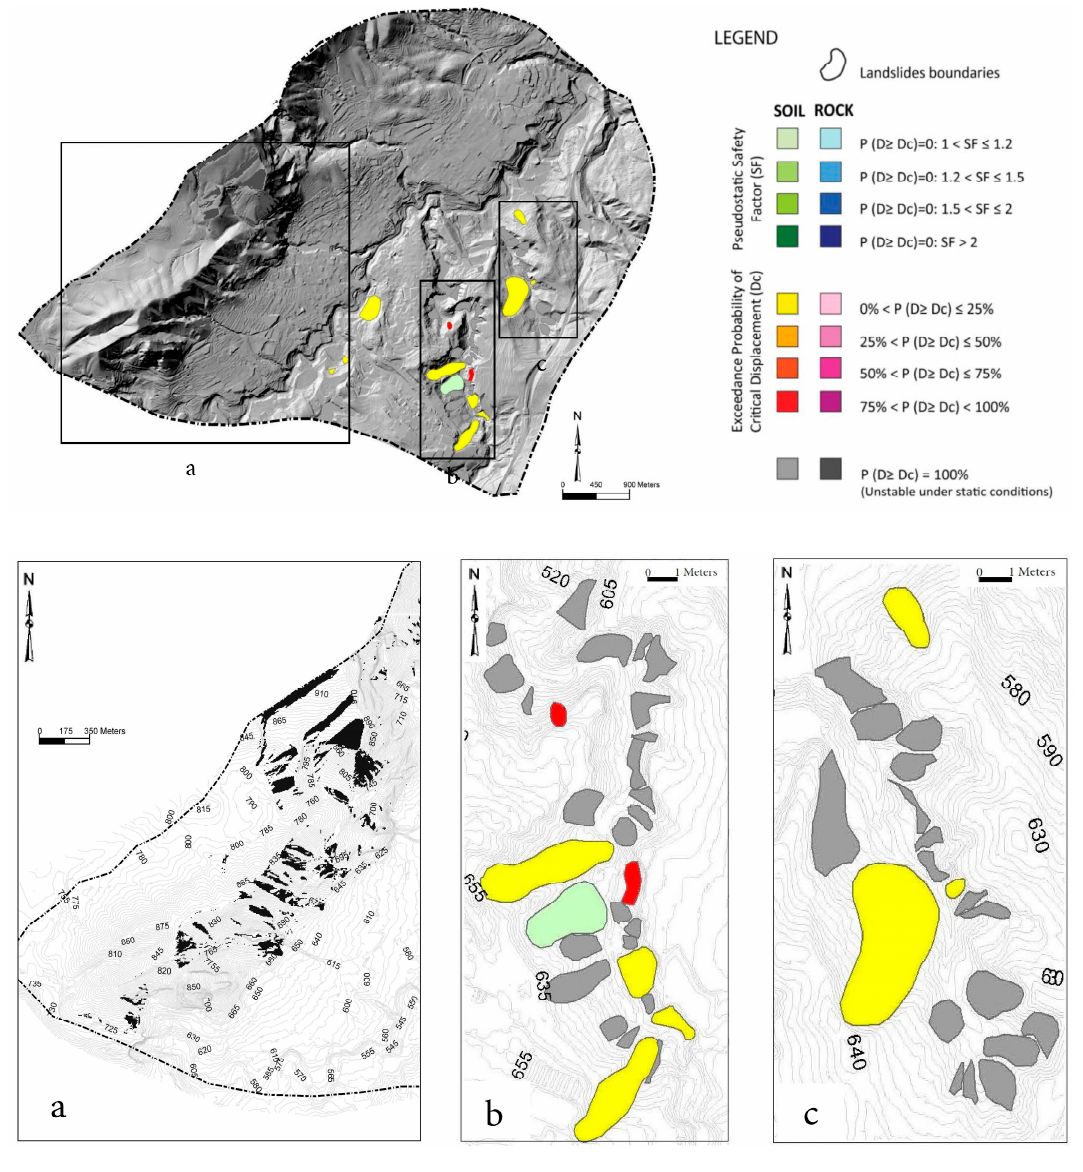
Figure 13. Resulting scenario by PARSIFAL obtained in the Alcoy urban area for RT = 475 years in full saturation conditions (the zoomed areas—a, b, c—are bounded in the key map).